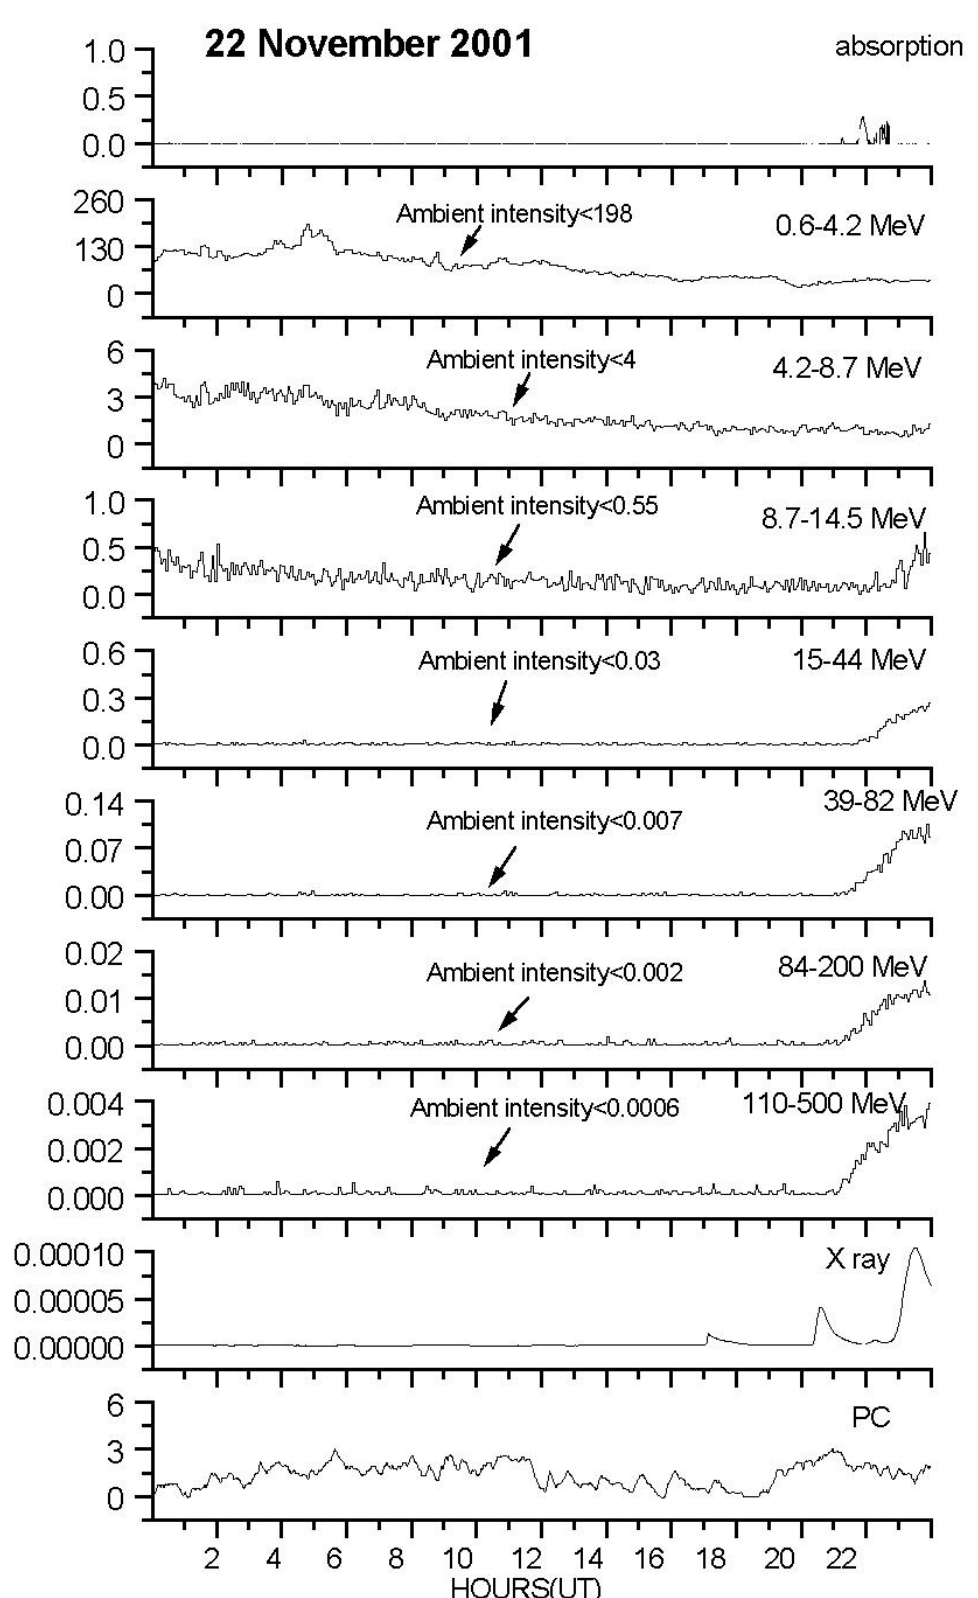
Fig. 6. As Fig. 1, but for 22